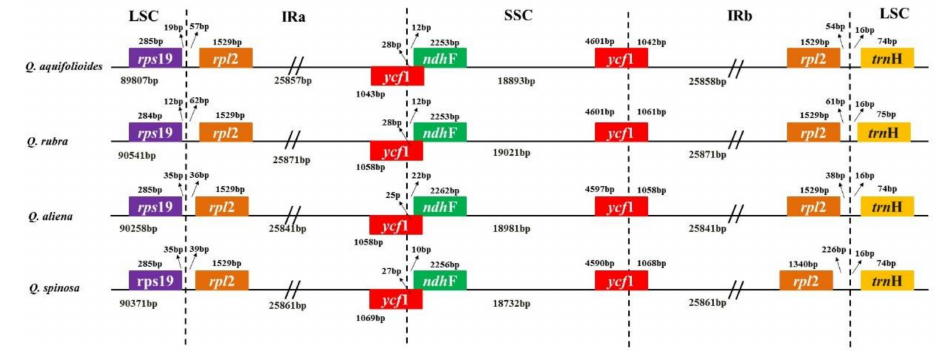
Figure 5. Comparisons of borders between neighboring genes and junctions of the LSC, SSC, and IR regions among the four Quercus cp genomes. Boxes above or below the main line indicate genes adjacent to borders. The figure is not to scale with regard to sequence length and shows only relative changes at or near (inverted repeats/single copy) IR/SC